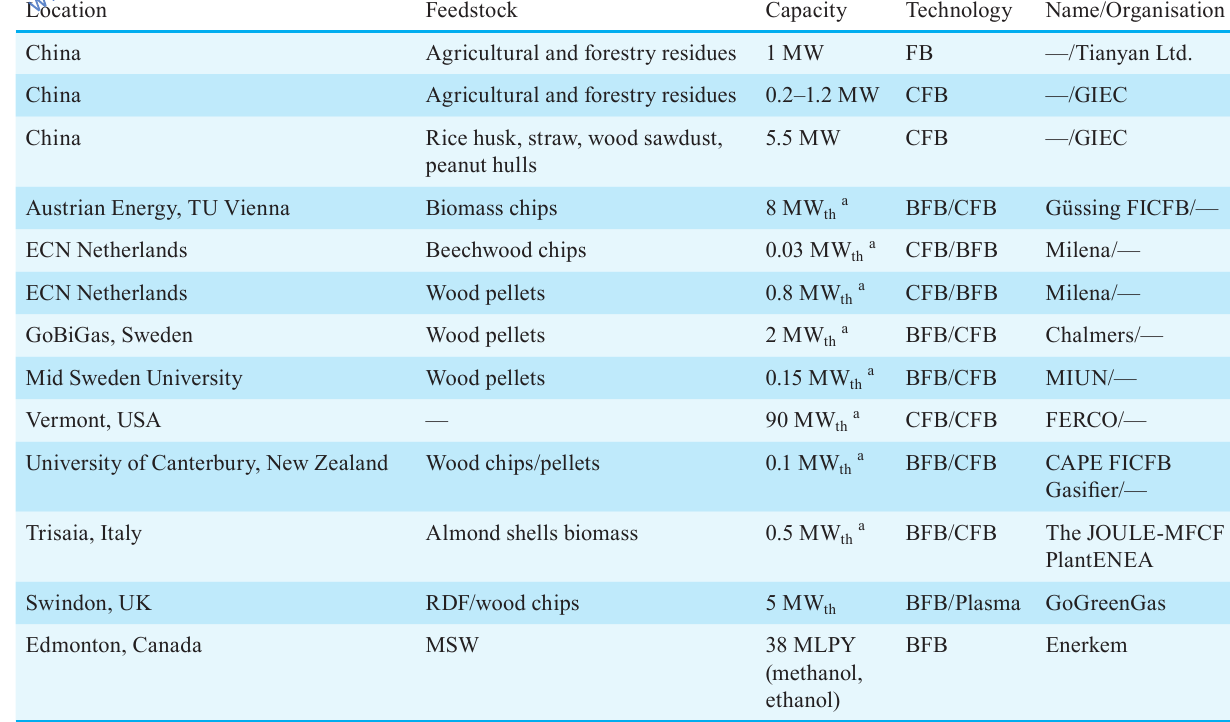
Table 4 Gasification systems worldwide using fluidised bed reactors.